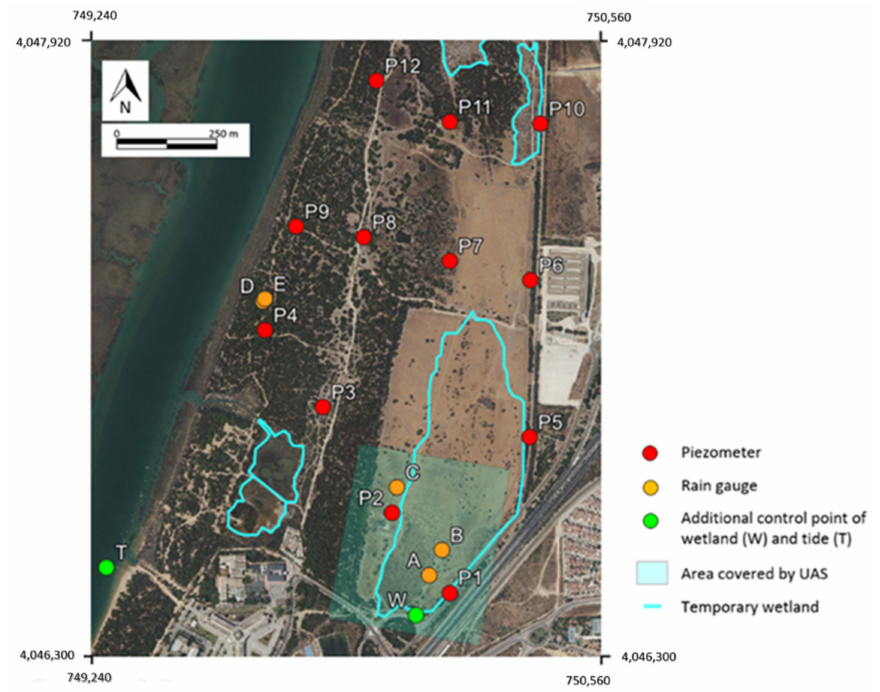
Figure 6. Hydrological monitoring